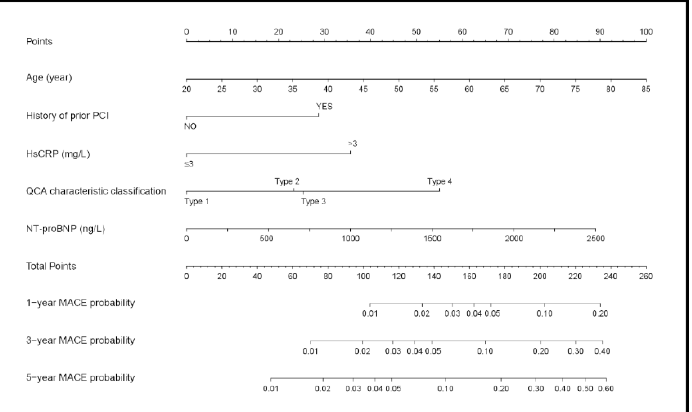
Figure 3. Nomogram for MACE prediction. Draw a perpendicular line from the corresponding axis of each risk factor until it reaches the top line labeled “Points.” Sum up the points of all risk factors then draw a line descending from the axis labeled “Total Points” until it intercepts each of the risk axes to determine 1-, 3-, and 5-year MACE probabilities.